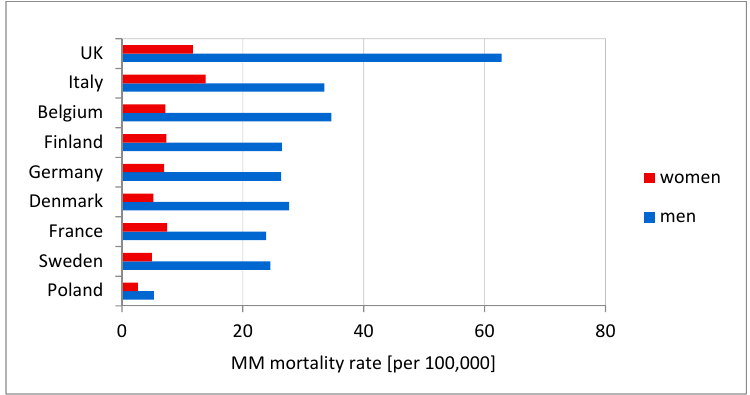
Figure 7. MM mortality rates in selected European countries.